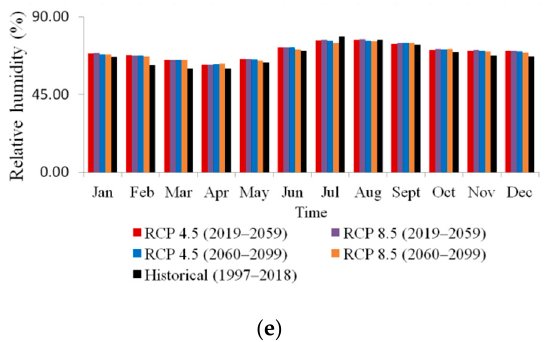
Figure 3. Characteristics of future seasonal ( a ) precipitation, ( b ) maximum temperature, ( c ) minimum temperature, ( d ) wind speed, and ( e ) relative humility under two climate change scenarios. Table 2. Future changes of the annual averages of daily max / min temperature and annual precipitation at the Jeonju weather station. Climate